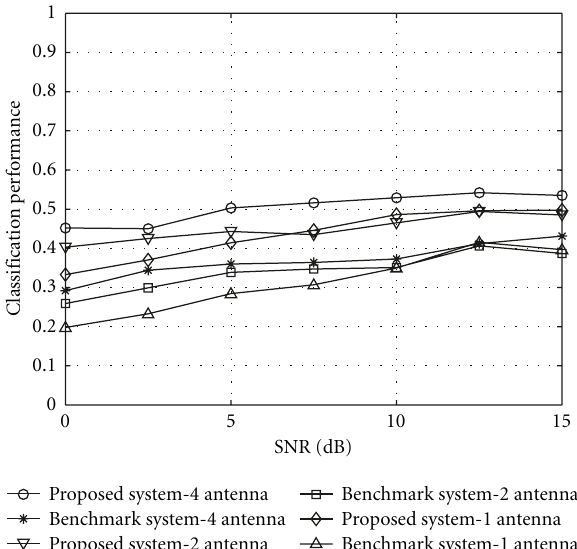
Figure 14: Final classification performance of proposed classifier and benchmark in a slow two-path fading channel using SC.